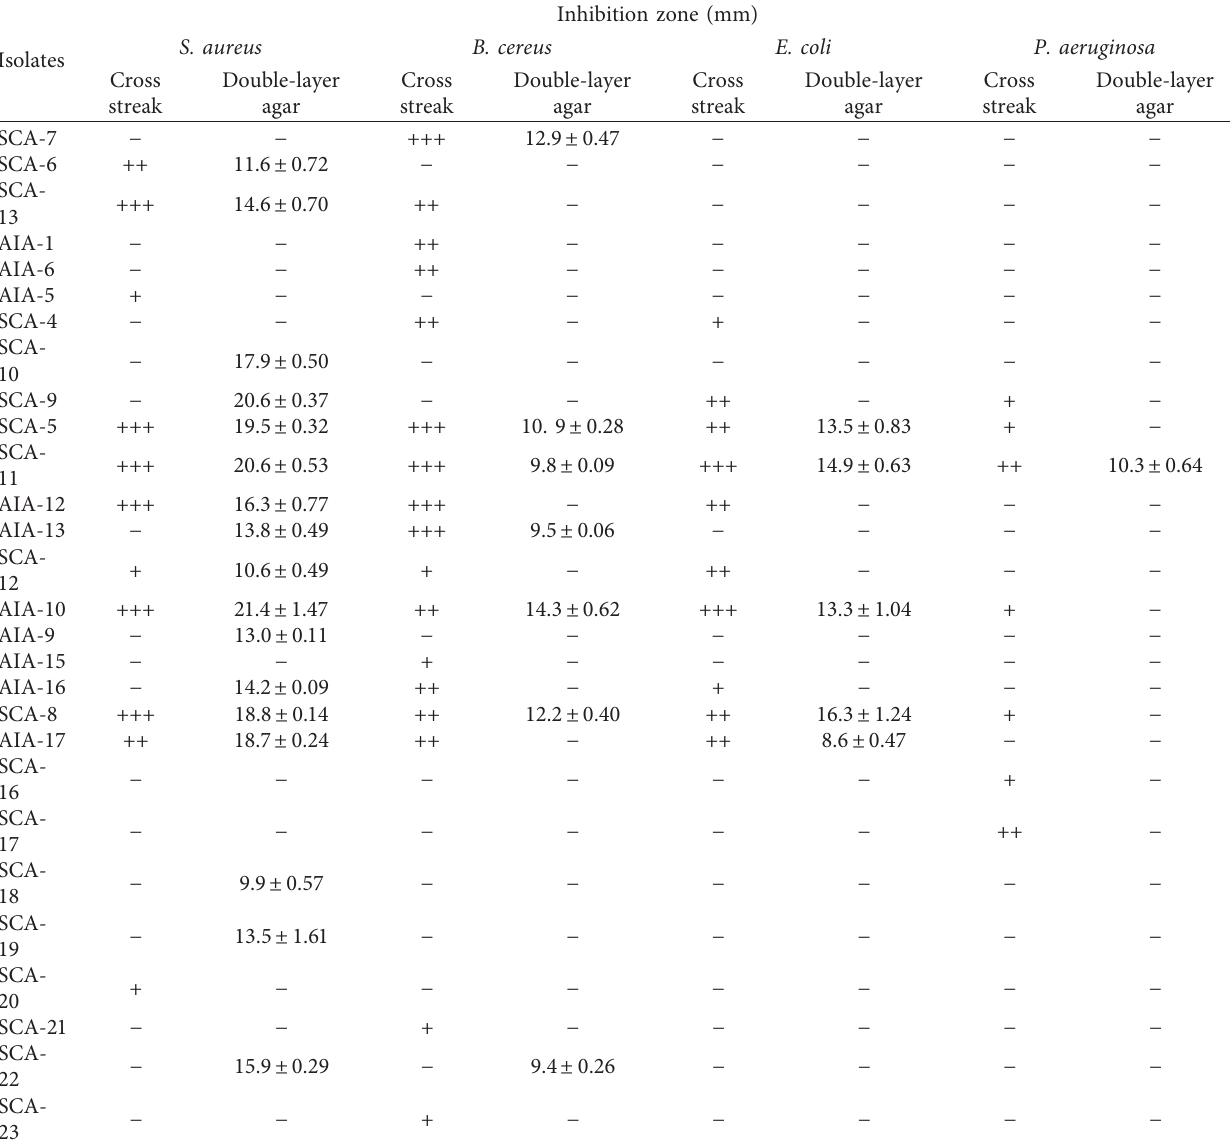
Table 1: Preliminary screening using cross streak and evaluation of antibacterial activity using double-layer agar diffusion. Isolates